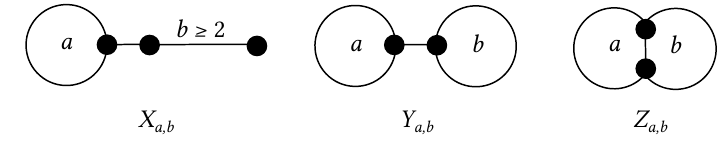
Figure 1: Examples of molecular graphs whose Sombor index is independent of the size ( a, b ) of their cycles; n = number of vertices; SO ( X a,b ) = √ 5 + 3 √ 13 + ( n